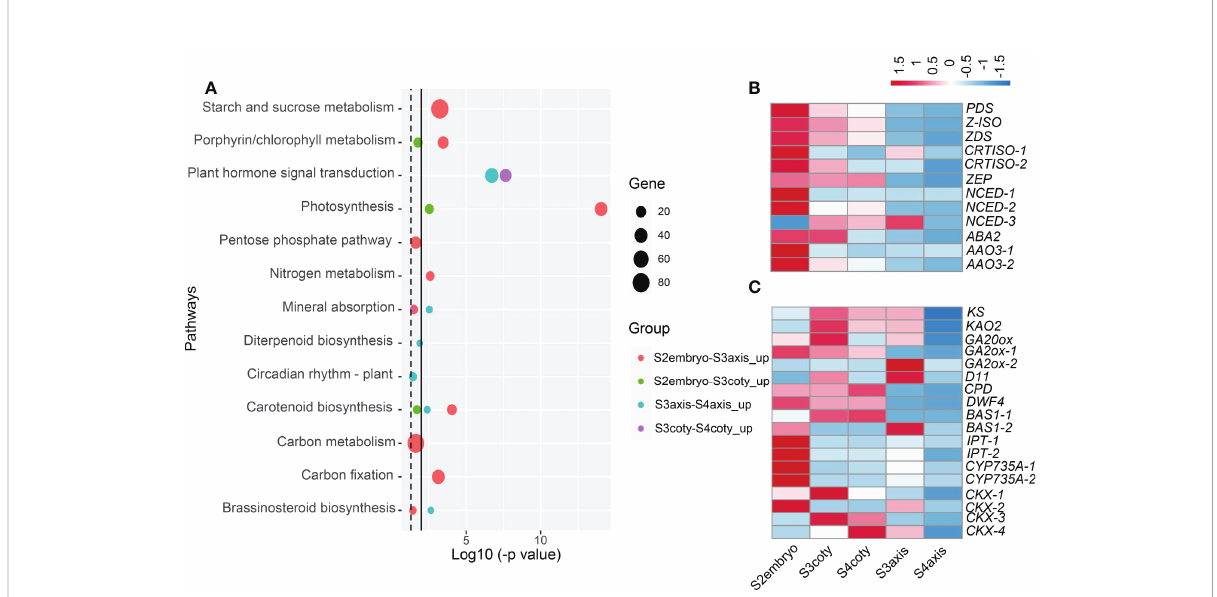
FIGURE 4 Candidate pathways and hormonal gene expression pattern during viviparous embryonic growth. (A) Enriched KEGG pathways compared embryonic tissues in adjacent stages; dotted line indicates p-value ≤ 0.05, while the solid line is ≤ 0.01. Circle colors represent different groups of genes, and circle sizes re fl ect gene numbers. (B) Expression heatmap of ABA biosynthesis genes, color means z-score, redder color means expression count with higher mean value while bluer is lower. Genes: ABA2 , ( xanthoxin dehydrogenase ); AAO , ( abscisic-aldehyde oxidase ); NCED , ( 9-cis-epoxycarotenoid dioxygenase ); PDS , ( 15-cis-phytoene desaturase ); ZEP , ( zeaxanthin epoxidase ); ZDS , ( zeta-carotene desaturase ); (C) Expression pattern of GA, BR, cytokinin metabolism genes, KAO2 , ( ent-kaurenoic acid oxidase ); KS , ( ent-kaurene synthase ); GA20ox , ( GA 20-oxidase ); GA2ox , ( GA 2-oxidase ); D11 , ( CYP724B1 ); CPD , ( CYP90A1 ); DWF4 , ( DWAF4 ); BAS , ( CYP734A1 ); IPT , ( isopentenyl transferase ); CKX , ( cytokinin dehydrogenase